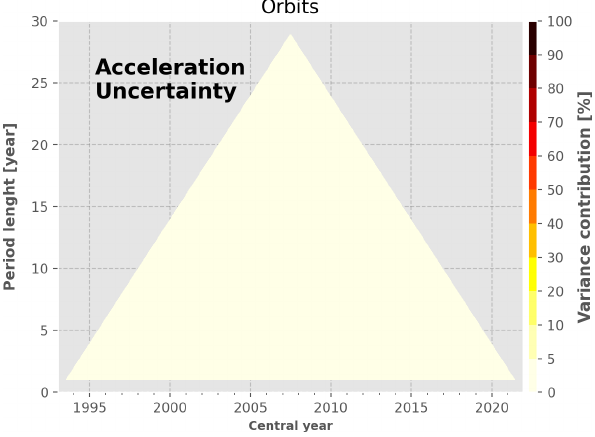
Figure B1. Variance contribution to the GMSL acceleration vari- ance of the high-frequency errors correlated at 2 months.